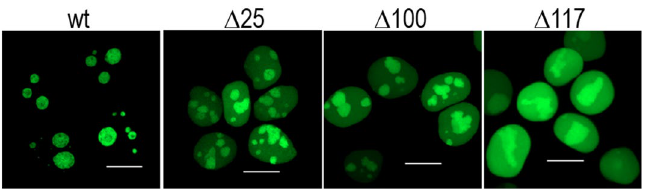
Figure 4. Significance of the N-terminus for NPM localization. Diminished nucleolar accumulation and increased amount in the nucleoplasm of Δ25, Δ100 and Δ117 compared to